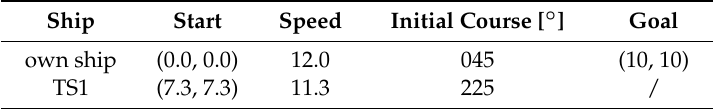
Table 7. Initial inputs for the simulation of emergency